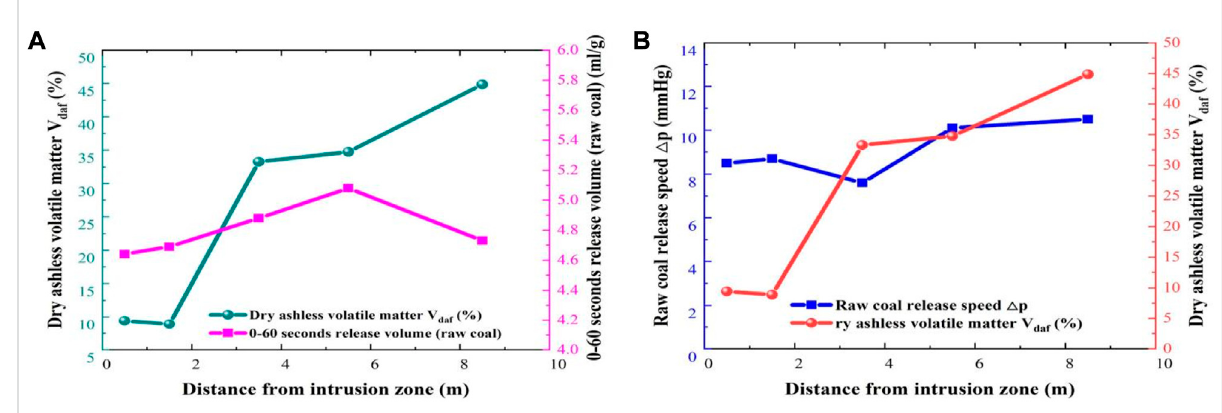
as the attenuation coef fi cient. The curve of V 1 via V daf is shown in Figure 13, with fi tting formula of Eq. 13, and R 2 of 0.98. The V 1 value of the 2# and 6# coal samples is signi fi cantly larger than that of the other coal samples. With the increase of volatile matter, the V 1 decreases monotonically, satisfying the quadratic nonlinear relationship.